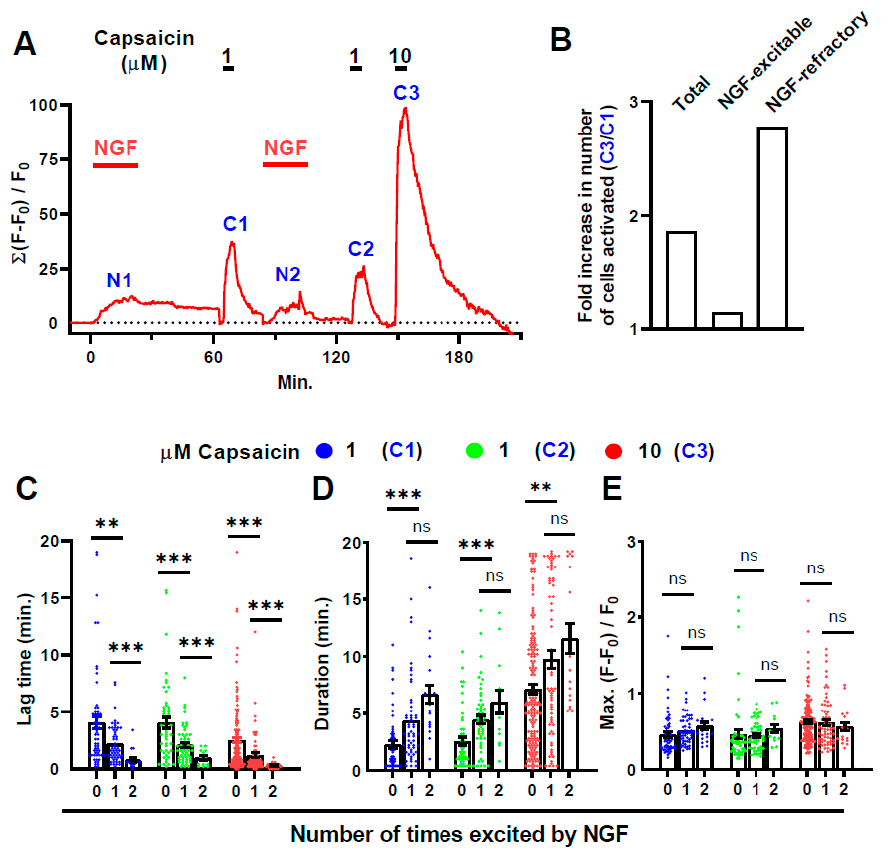
Figure 6. NGF evokes signals if applied before CAPS and excites a new cohort when re-applied afterwards; CAPS-induced signal strength correlates with responsiveness to NGF. ( A ) Summed increase in fluorescence from DRG treated, in the following order, with 100 ng/mL NGF (20 min followed by 40 min washout, [N1]); 1 µ M CAPS (5 min, 15 min washout, [C1]); NGF for a second time (20 min, 20 min washout, [N2]); 1 µ M CAPS again (5 min, 15 min washout, [C2]) and, finally, 10 µ M CAPS (5 min, 35 min washout, [C3]). ( B ) Shows the relative increase in the number of active cells (number activated by 10 µ M CAPS [C3]/number excited by 1 µ M [C1]) calculated for all CAPS- excitable cells (Total) or only the subsets that were NGF-excitable and -refractory cells. ( C – E ) Neurons that responded during the first ([C1]; blue dots) or second exposure ([C2]; green dots) to 1 µ M CAPS and those excited by 10 µ M CAPS ([C3]; red dots) were sub-categorised according to whether they were excited both times (2, abscissa) on exposure to NGF (i.e., during [N1] and [N2]), only once (1, abscissa) by either application (i.e., [N1] or [N2]) or remained inactive both times (0, abscissa). Each sub-category was analysed for ( C ) lag time, ( D ) signal duration and ( E ) Max. intensity. Plotted data represents mean ± s.e.m. Asterisks indicate p values for Student’s t -tests compared between group 1 and the requisite data set in group 0, or between groups 1 and 2. ** p < 0.01; *** p < 0.001; ns, not significant. Detailed results are provided in Supplementary Tables S9 and